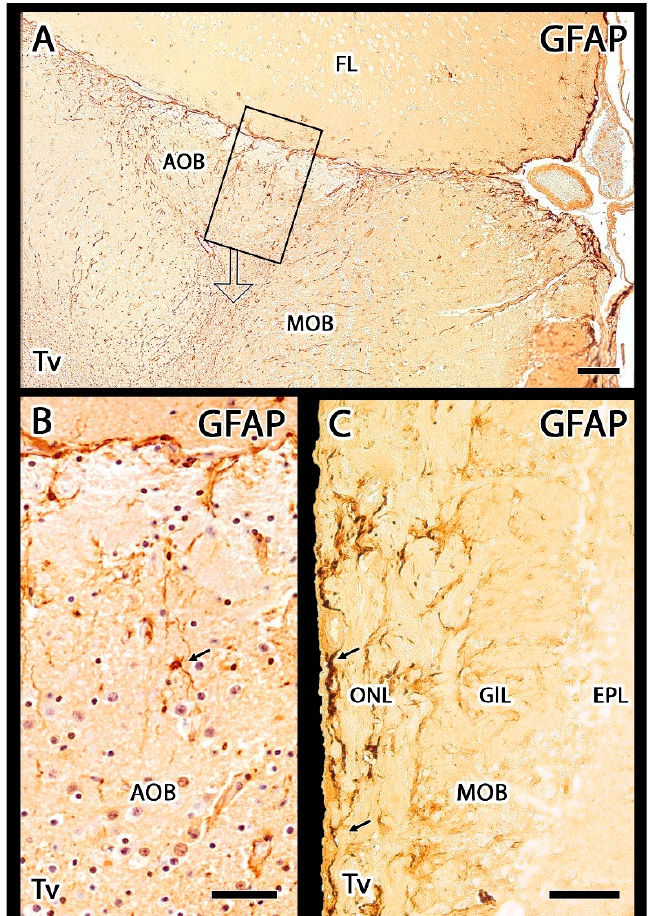
Figure 9. Immunohistochemical labelling of the meerkat OB with anti-GFAP. ( A ) Anti-GFAP produces a strong labelling in the nerve layer of both the accessory and ( C ) main olfactory bulbs. The labelling in these layers corresponds to glial cell fibers, mainly ensheathing cells. ( B ) Enlargement of the box in ( A ) after hematoxylin counterstaining, showing fibers and astrocytes in the mitral-plexiform layer of the AOB (arrow). ( C ) In the MOB there is a remarkable presence of astrocytes in the superficial layers (arrows). Scale bars: ( A , C ) 100 μ m; ( B ) 50 μ m.